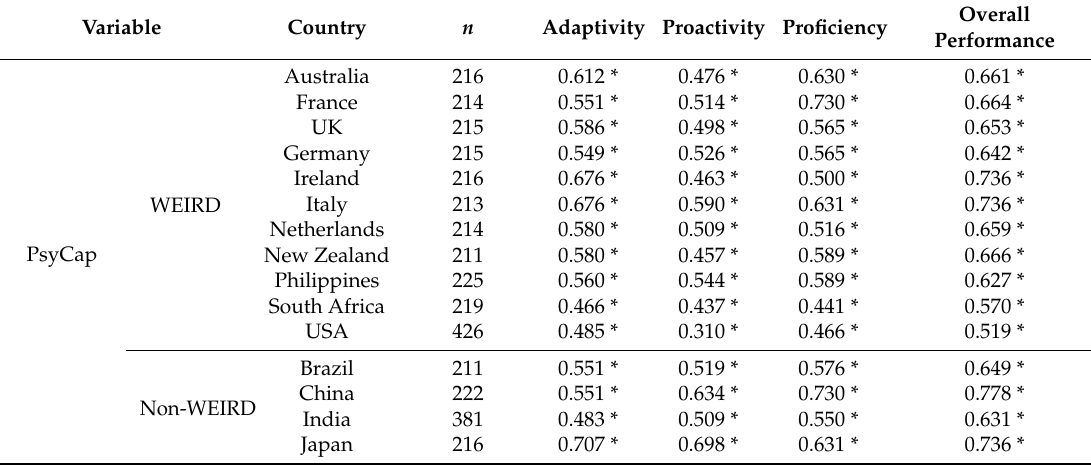
Table 3. Percent variance contributed by PsyCap to job performance by